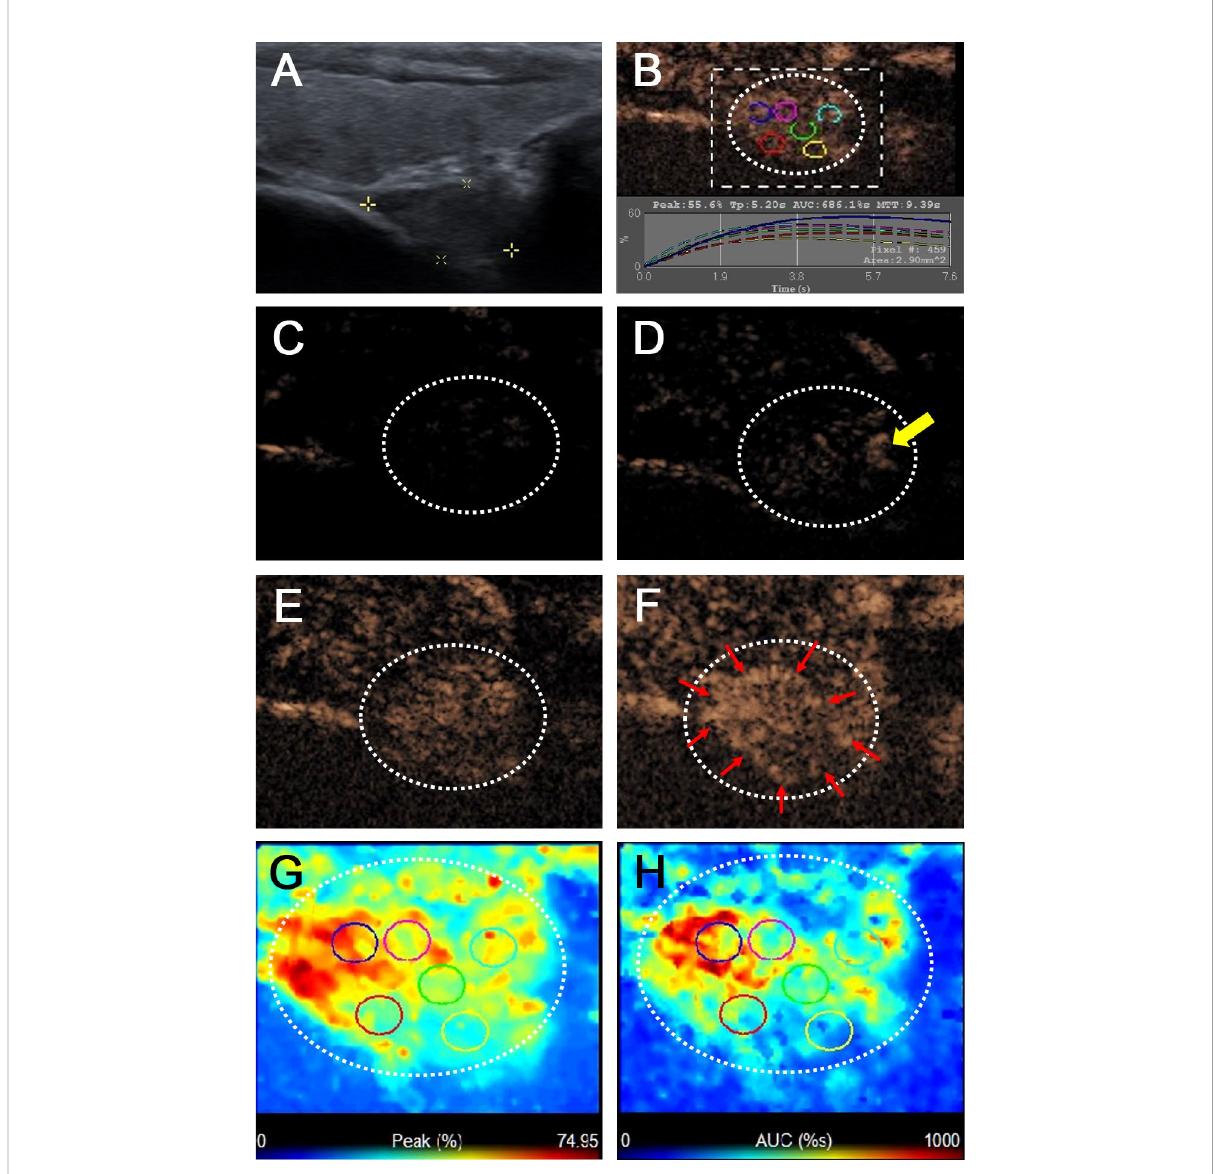
FIGURE 2 Metastatic lymph node in a 38-year-old female patient with PTC. (A) The metastatic foci in a right paratracheal CCLN (white cross) identi fi ed on conventional US, showing L/S <2, absence of fatty hilum and hyperechoic appearance. (B) Time-intensity curve of CCLN. (C – F) CEUS images at different times, (C) before injection of contrast agent, the CCLN showed no microbubbles signal; (D) at 9 s, the CCLN showed the microbubbles signal from the periphery of the lymph node (yellow arrow); (E) at 11 s, the whole CCLN showed heterogeneous enhancement, which is equal to the surrounding thyroid tissue; (F) at 13 s, the whole CCLN showed heterogeneous hyper-enhancement with a ring enhancement (red arrows), which is higher than the surrounding thyroid tissue. (G, H) Parametric color maps of PI and AUC values, PI and AUC values of the whole lymph nodes (yellow and red colors) was higher than the surrounding tissue (blue color), means PI index >1 and AUC index >1, (G) PI values for the periphery of CCLN were higher than those of the center of CCLN, which were heterogeneous of the whole CCLN; (H) AUC values for the periphery of CCLN were higher than those of the center of CCLN, which were also heterogeneous of the whole